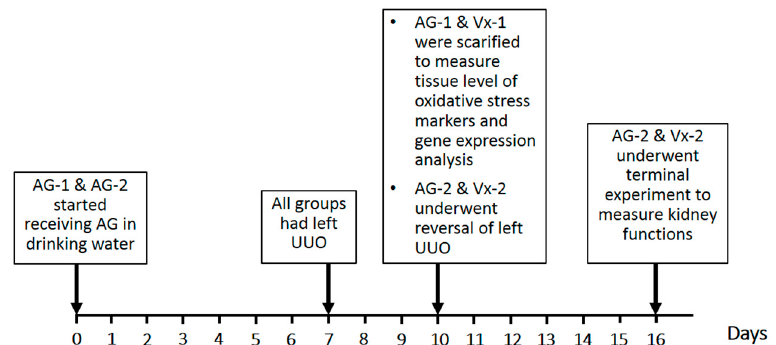
Figure 1. Schematic presentation of the study plan showing interventions in all groups. AG is Arabic gum, UO is ureteric obstruction, UUO is unilateral UO.